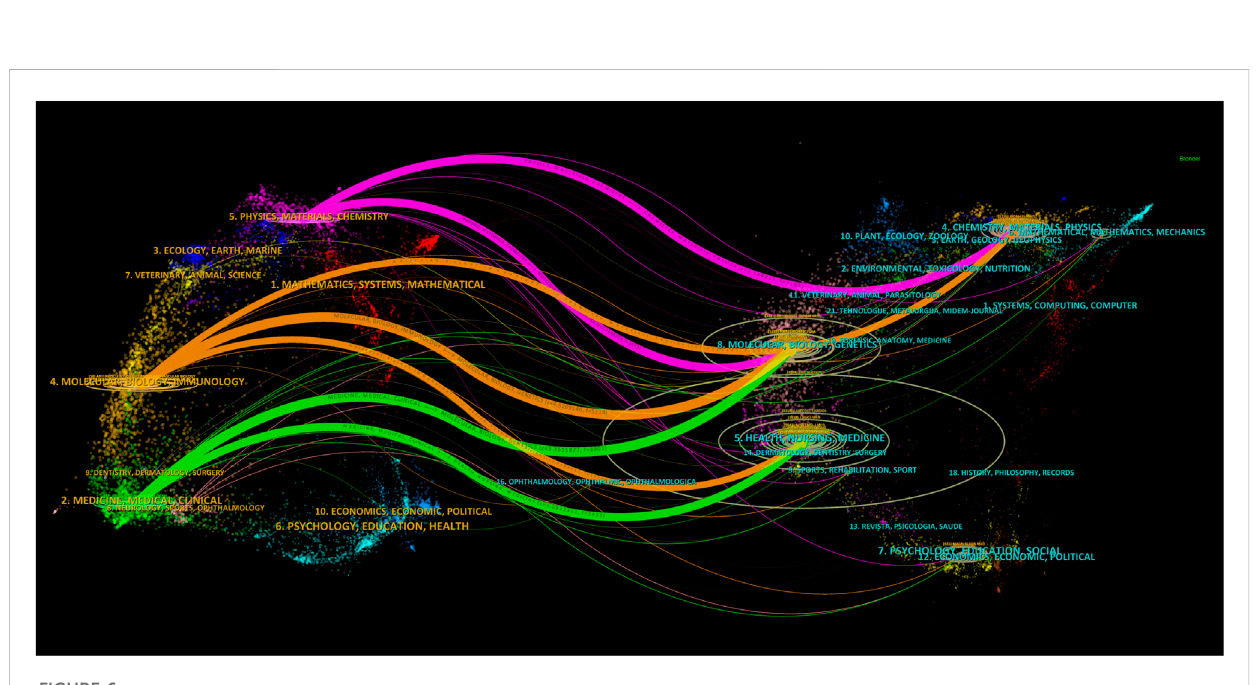
FIGURE 6 A dual map overlap of journals on molecular imaging research in AS performed with